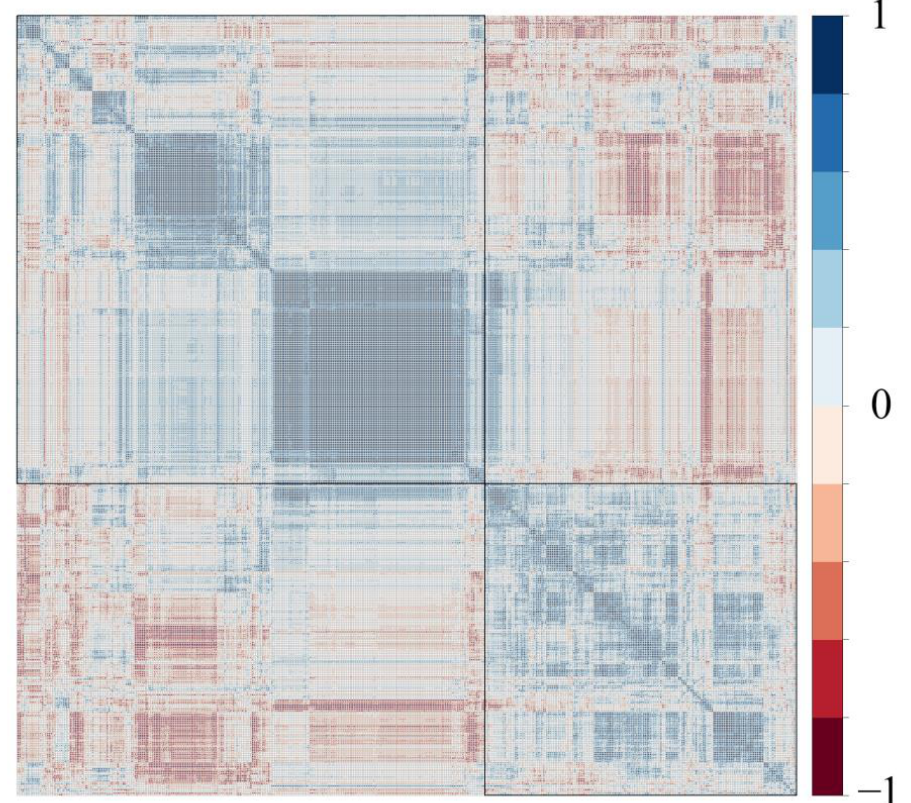
Figure 7. Correlation map of variables selected by RF for integrated analysis of the microbiome, metabolome and transcriptome, where the red color and blue color represent negative correlation and positive correlation, respectively.